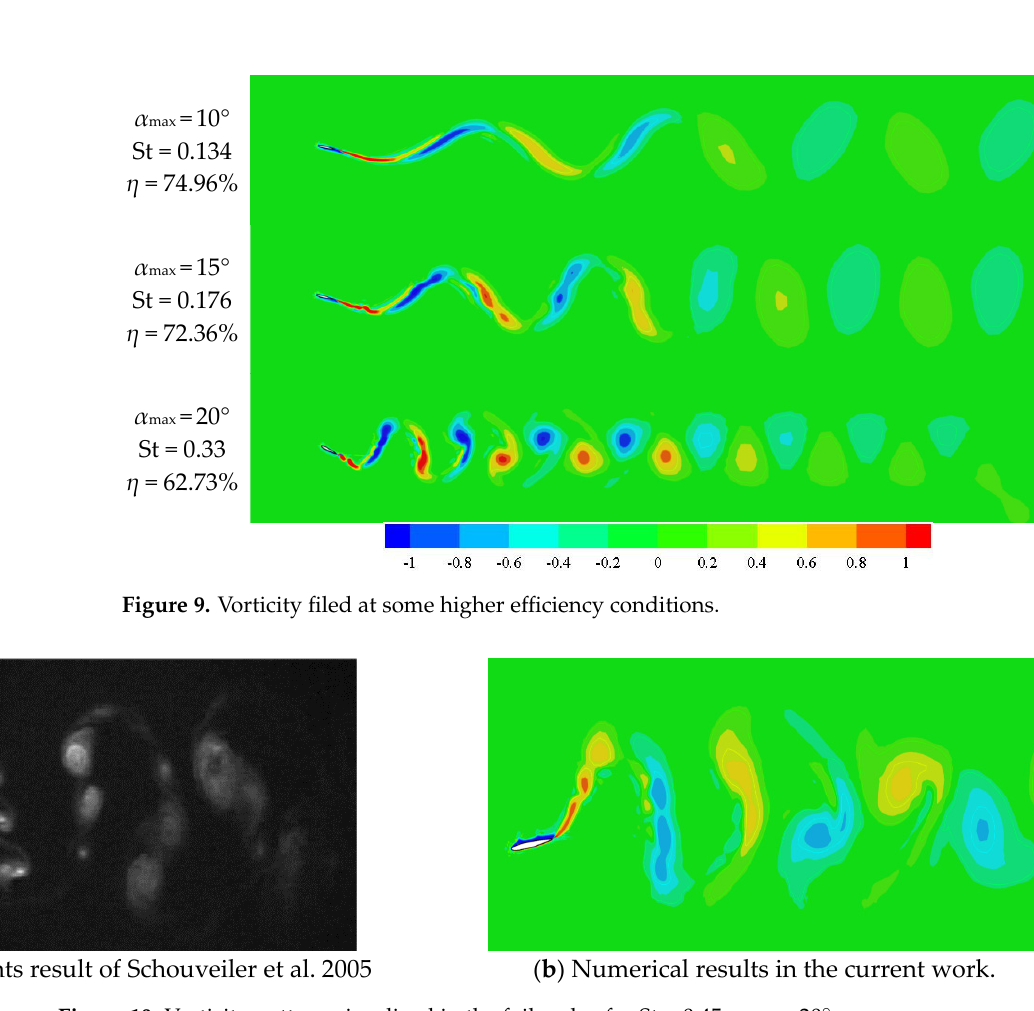
Figure 8. Comparisons of the propulsive efficiency η and the thrust coefficient c T with previous computational and exper- imental results. at different a max. ( a ) Propulsive efficiency comparison with a max = 10°; ( b ) Thrust coefficient comparison with a max = 10°; ( c ) Propulsive efficiency comparison with a max = 15°; ( d ) Thrust coefficient comparison with a max = 15°; ( e ) Propul-